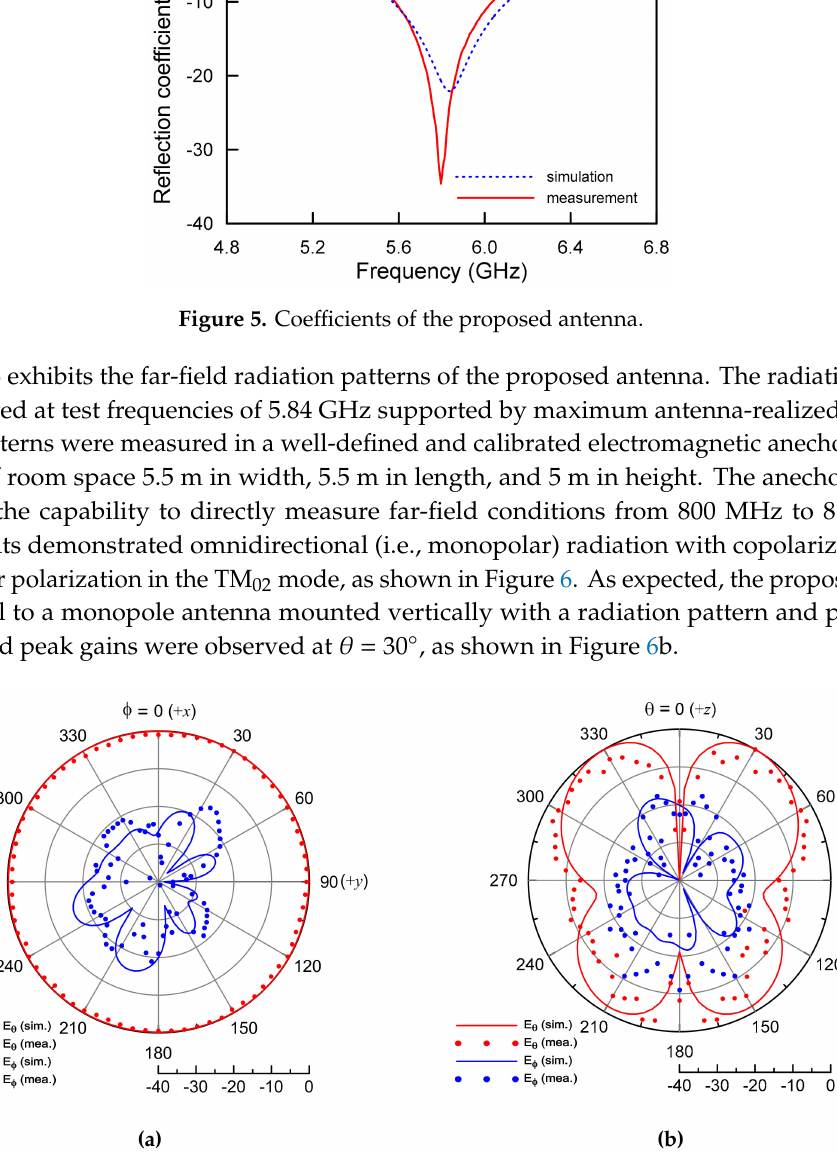
Figure 6. Radiation patterns of the proposed antenna at a resonant frequency of 5.84 GHz: the ( a ) H -plane ( x–o–y plane) and ( b ) E -plane ( z–o–x